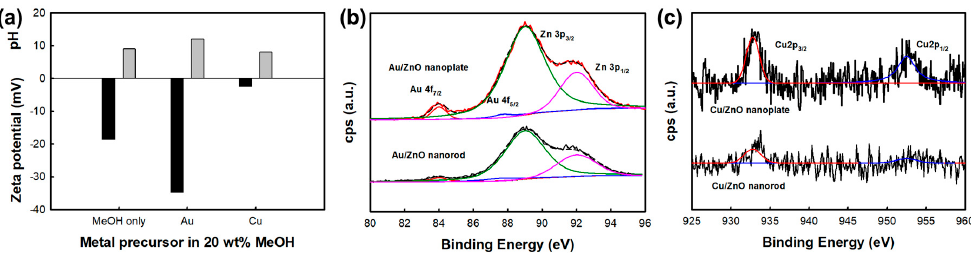
Figure 3. ( a ) Zeta potential of ZnO nanostructures in metal precursor solution (black bar) and pH of metal precursor solution (gray bar). The concentration of the metal precursor is 0.1 mM, ( b ) XPS Au 4f spectra of Au / ZnO nanostructures, and ( c ) XPS Cu 2p spectra of Cu / ZnO